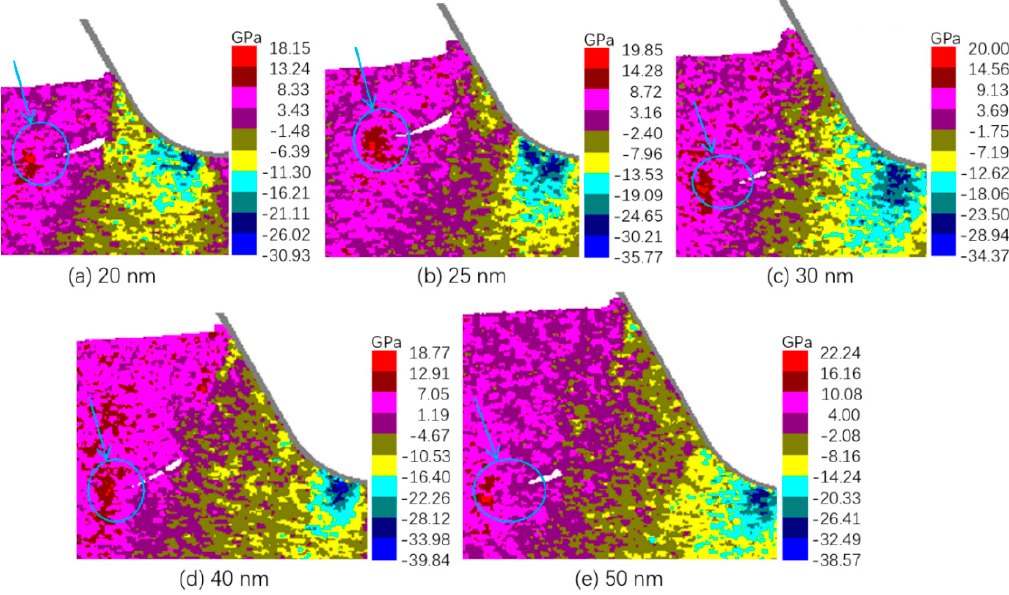
Figure 5. Distribution of σ (cid:2935)(cid:2935) at crack formation.